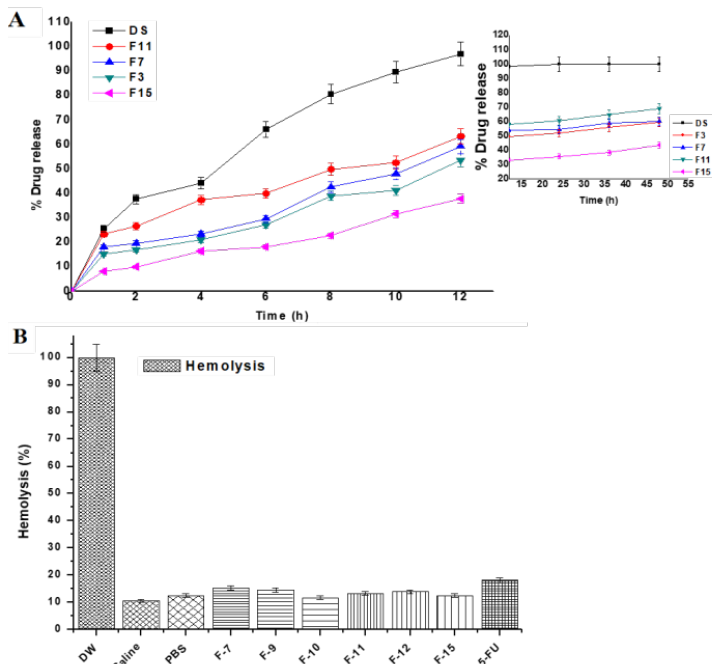
Figure 4. ( A ) In vitro biphasic (0–12 and 12–48 h) drug release profile of the formulations and ( B ) In vitro hemolysis study of the developed gold nanoparticles over period of 4 h. Each sample was incubated with erythrocytes at 37 °C. DW (served as positive control) and PBS (buffer control) represent distilled water and phosphate buffer solution (pH 7.4), respectively. Data presented as mean ± sd ( n = 3).